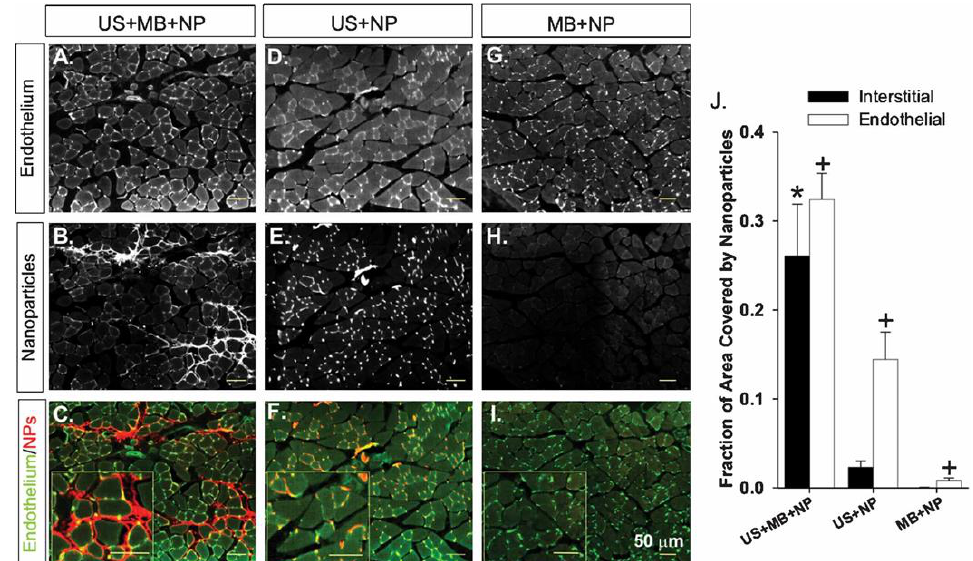
Figure 4. Muscle cross-sections illustrating nanoparticle (NP) delivery. ( A – I ) Representative images of sections taken from gracilis muscles treated with ultrasound (US) + microbubbles (MB) + nanoparticles (NP) ( A – C ), ultrasound + nanoparticles ( D – F ), and microbubbles + nanoparticles ( G – I ) are shown. Note the deposition of nanoparticles (red) in muscle treated with ultrasound + microbubble + nanoparticles. J: Bar graph representing the fraction of interstitial area (regions outside of muscle fibers and vascular structures) or endothelial cell area (cells comprising the walls of blood vessels) occupied by fluorescent polystyrene nanoparticles. Values are means with standard deviations. * Indicates significantly different ( p < 0.05) to the interstitial area of all other groups. + indicates significantly different ( p < 0.05) to the endothelial cell area of all other groups. Adapted from Chappell et al. [114].